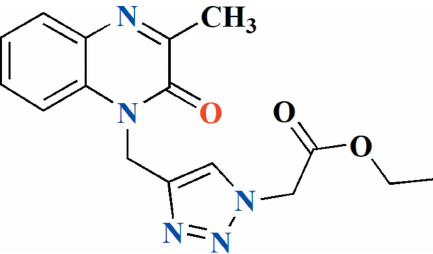
Table 1 Hydrogen-bond geometry (A˚ , (cid:2) ).